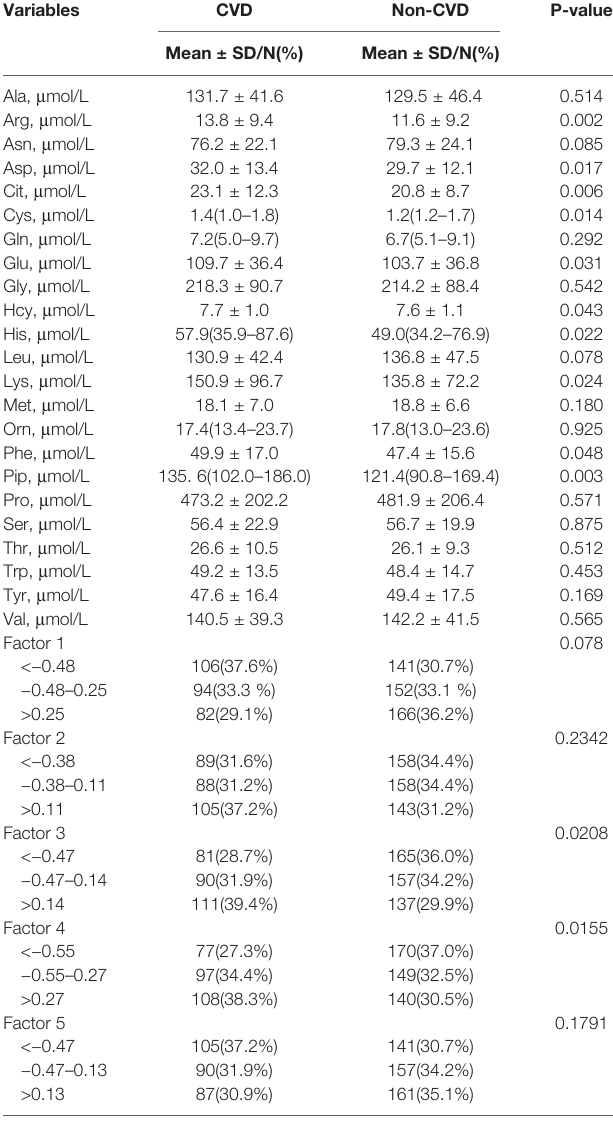
TABLE 2 | Amino acid pro fi le and identi fi ed factors by CVD status. Variables